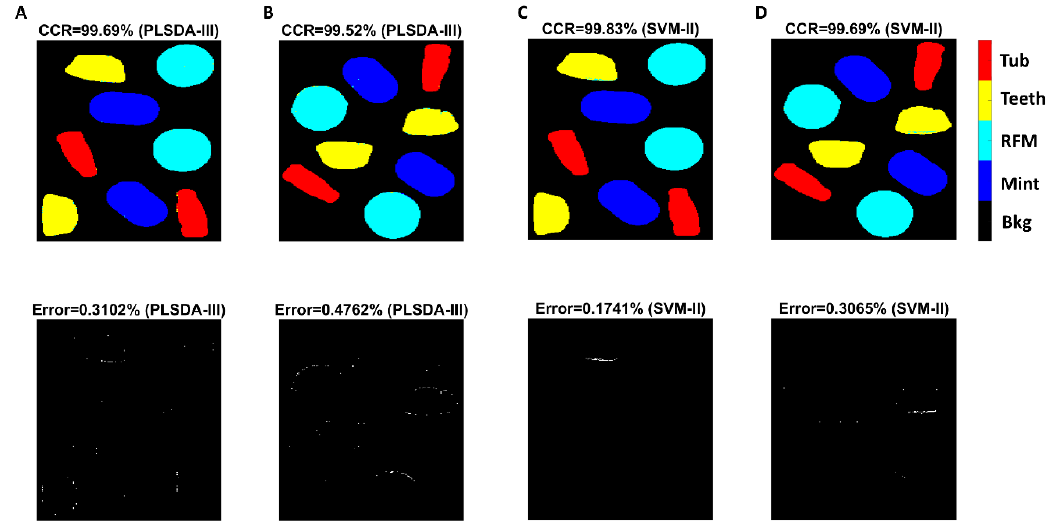
Figure 5. Classification and misclassification maps for Test 1 image ( A ) and Test 2 image ( B ) obtained from PLSDA ‐ III model; for Test 1 image ( C ) and Test 2 image ( D ) obtained from SVM ‐ II